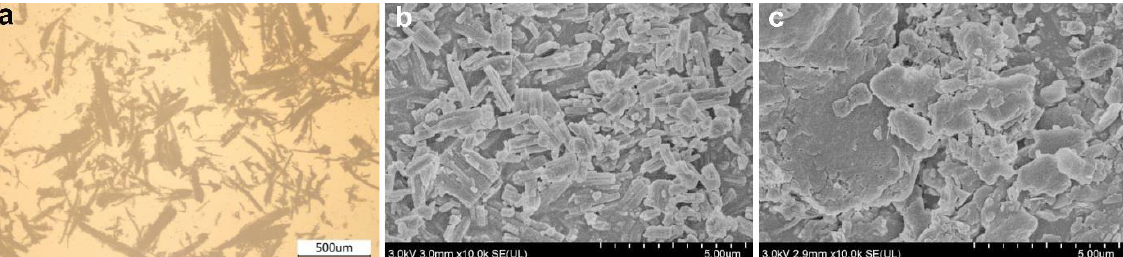
Figure 1. Optical micrographs of ( a ) wood flour used and SEM micrographs of ( b ) TMB5 and ( c ) WBG II. ( c ) WBG